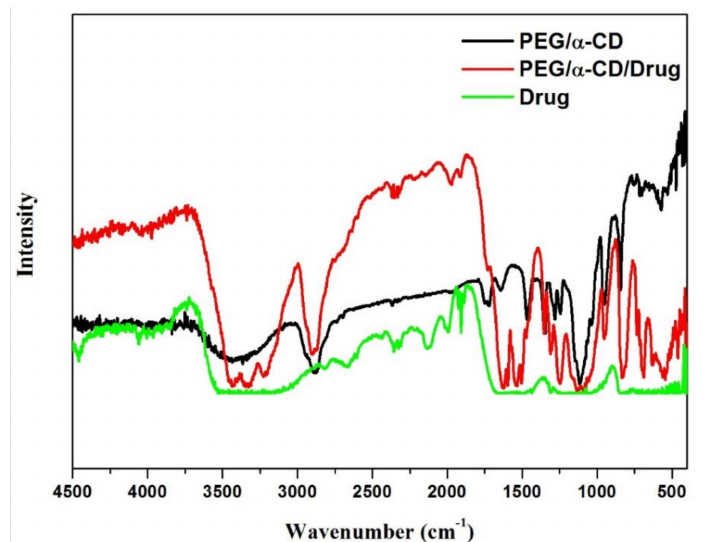
Figure 1. FT-IR spectra of sulfaguanidine drug (green), PEG/ α -CD (black), and PEG/ α -CD/Drug